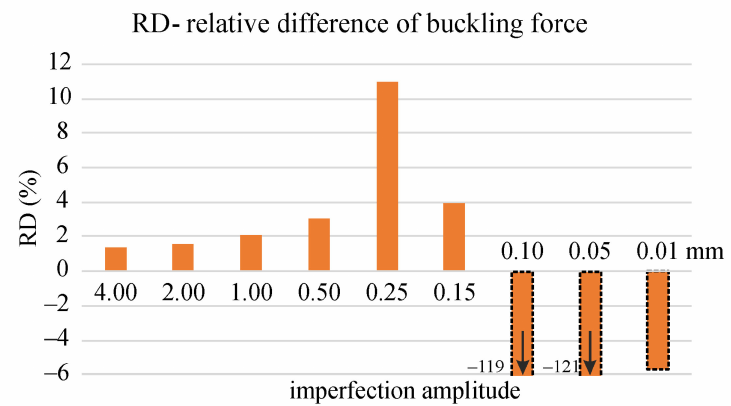
Figure 23. Relative difference between the critical forces obtained according to the nonlinear elastic and elastic-plastic